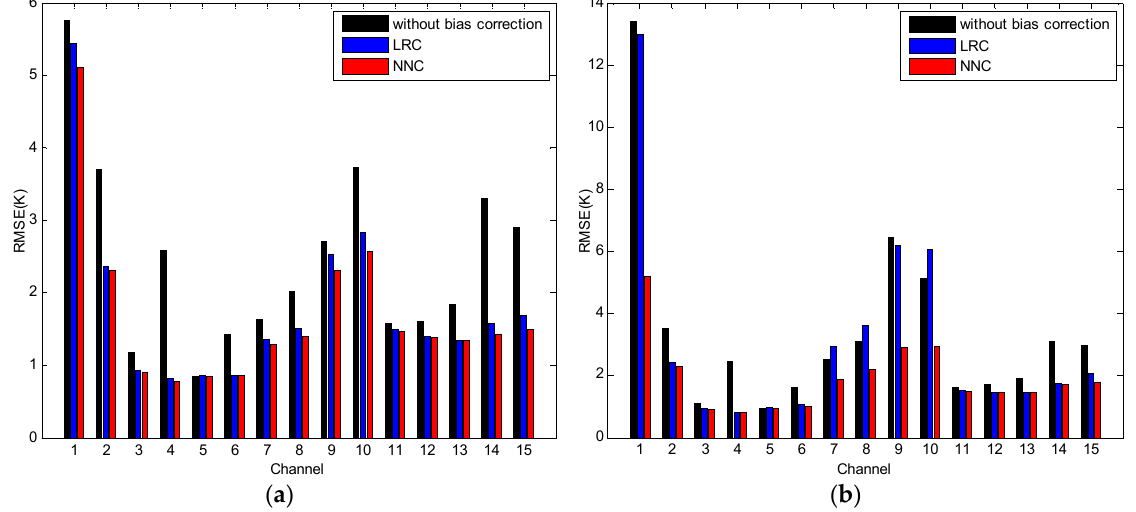
Figure 7. The RMSE of the biases before and after bias correction for MWHTS Channels 1–15. ( a ) Over ocean; ( b ) over land.